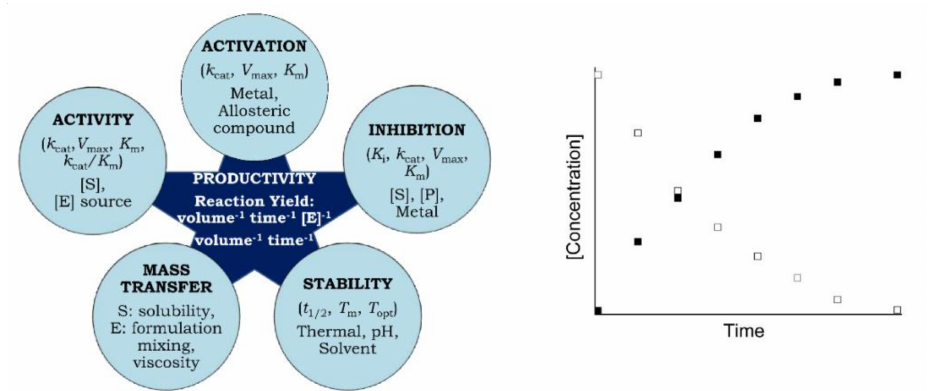
Figure 1. Concept and factors that influence enzymatic productivity. ( Left ): Complex dependency of productivity on the enzyme function, stability, and mass transfer parameters. ( Right ): Hypo- thetical basic productivity curves showing the formation of product (filled square) or consumption of substrate (open squares) as a function of time under optimal reaction conditions. [E]: Enzyme; [S]: Substrate; [P]: Product